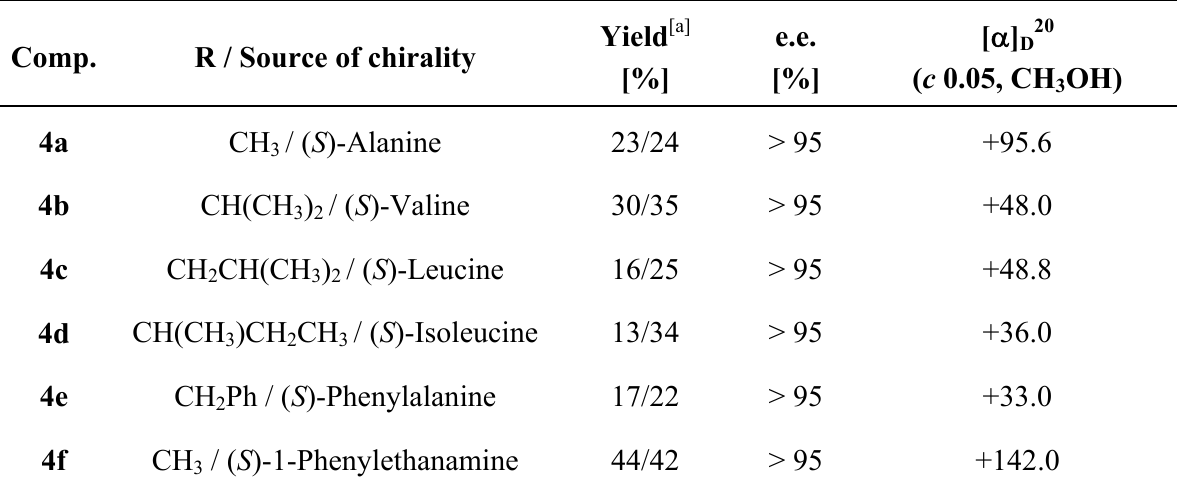
Table 2. Tridentate 4a-e and bidentate ligand 4f